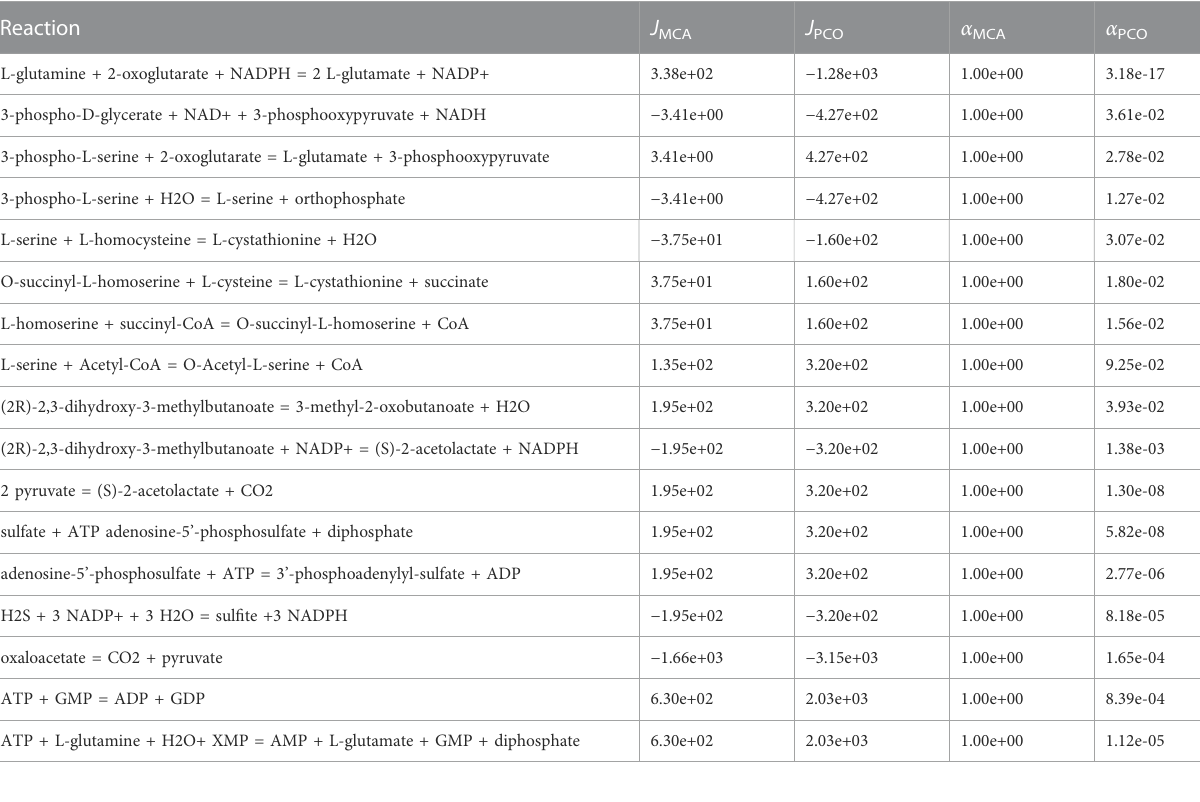
TABLE2ReactionsregulatedinthePCOmethodbutnotintheMCAmethodandthathavesigni fi cantreaction fl uxinthePCOmethod.Presumablythesereactions are regulated to control metabolite concentrations.